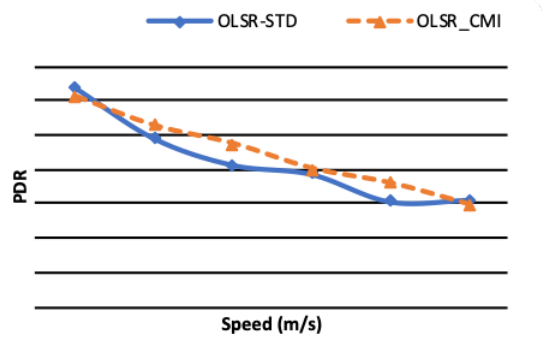
Fig. 5. PDR depending on the nodes speed